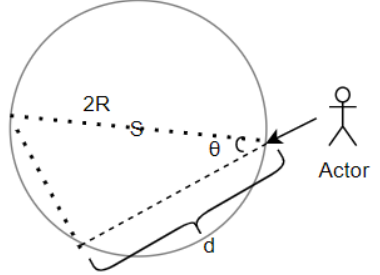
Figure 5. Campaign revenue model (for users not in the service).